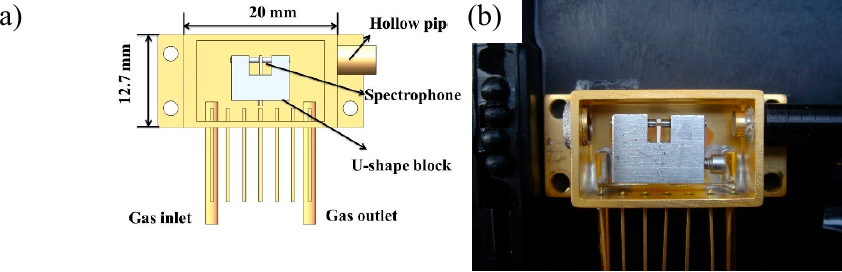
Figure 5. ( a ) CAD image of single-mode fiber-coupled ADM; ( b ) Photo of single-mode fiber-coupled ADM.